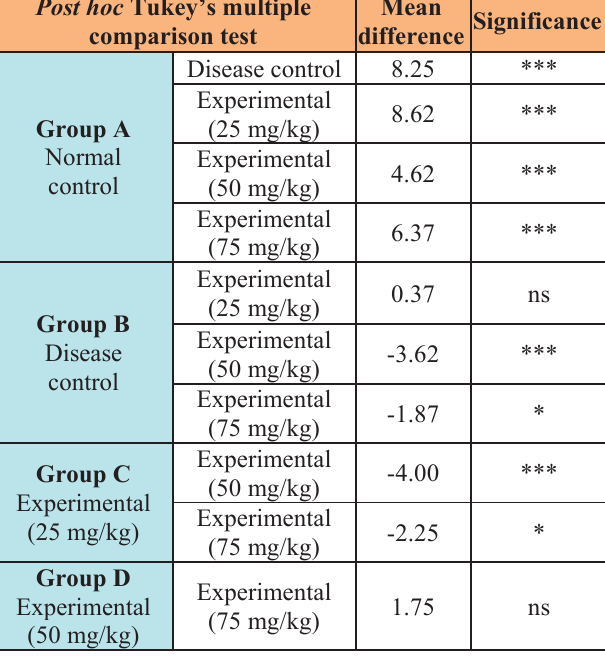
Table-3: Comparison of effect of carboplatin, apple peel extract and carboplatin plus 3 different doses of apple peel extract on erythroid cell percentage in bone marrow aspirate smear of mice by post hoc Tukey’s test (n=8) ns = not significant, * = p value <